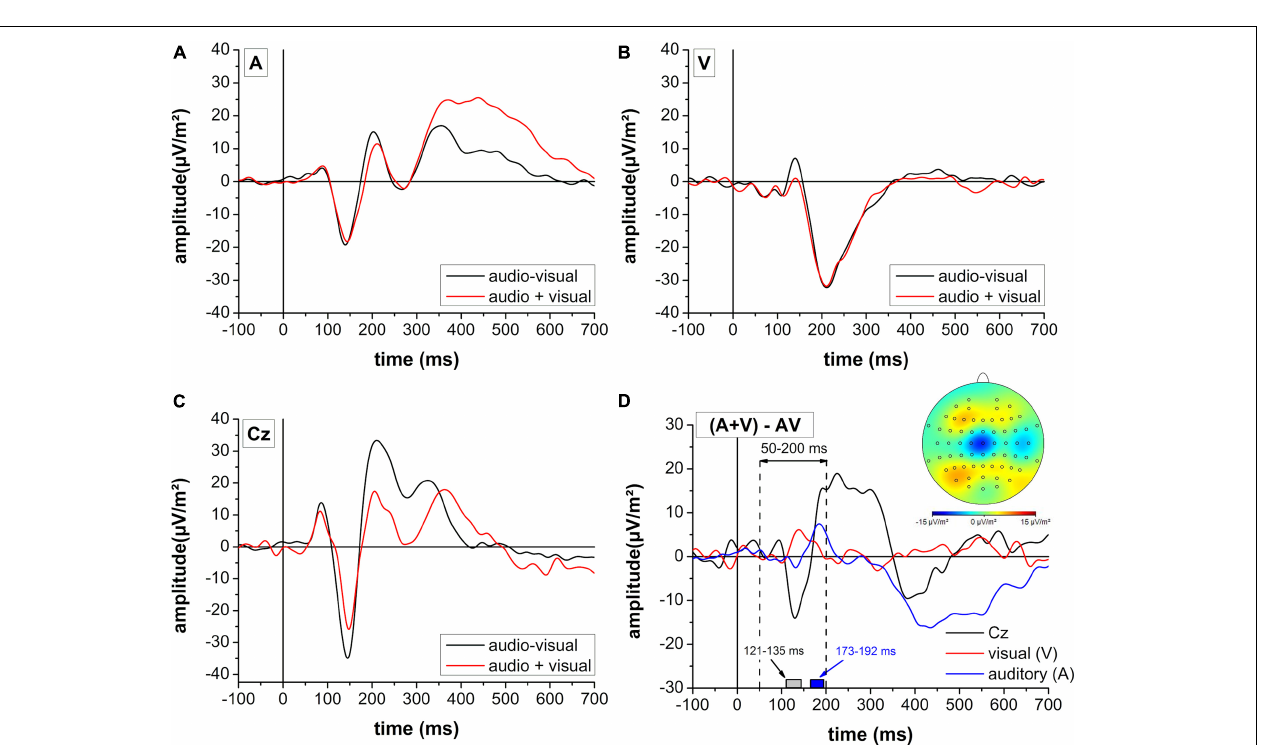
FIGURE 6 | Contrast of summed monosensory (audio + visual: red line) and multisensory (audio-visual: black line) cortical activity in auditory (A) and visual (B) areas as well as electrode position Cz (C) . (D) Difference profile of the summed monosensory (audio + visual) and combined multisensory (audio-visual) activity for the three regions of interest. The cortical mapping reflects a 10 ms peri-peak window centered at the negative peak in electrode position Cz. Gray and blue boxes reflect the time periods of significant differences in electrode position Cz and the auditory region, respectively derived from the FDR-corrected multiple t -test analysis. Please note a different scaling for panel (D) when compared to panels (A–C)